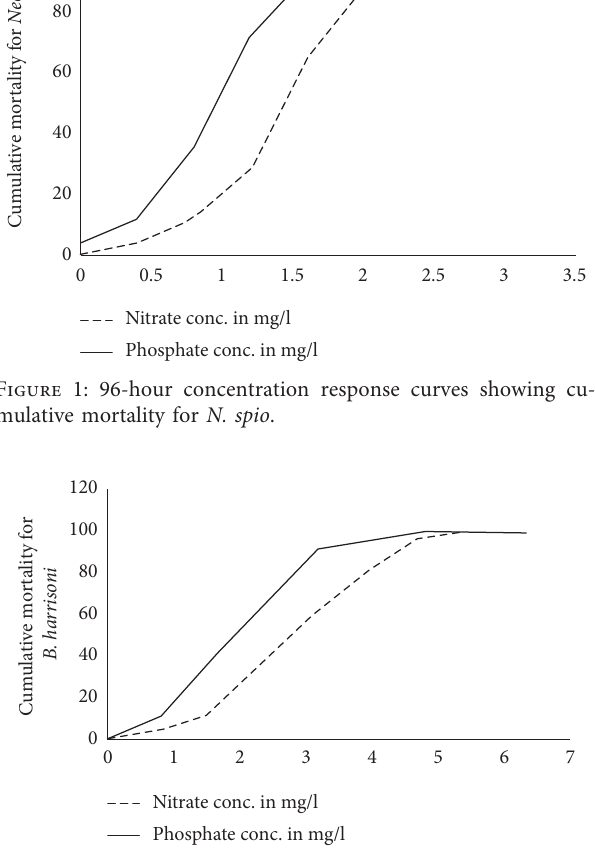
Figure 2: 96-hour concentration response curves showing cu- mulative mortality for B. harrisoni .